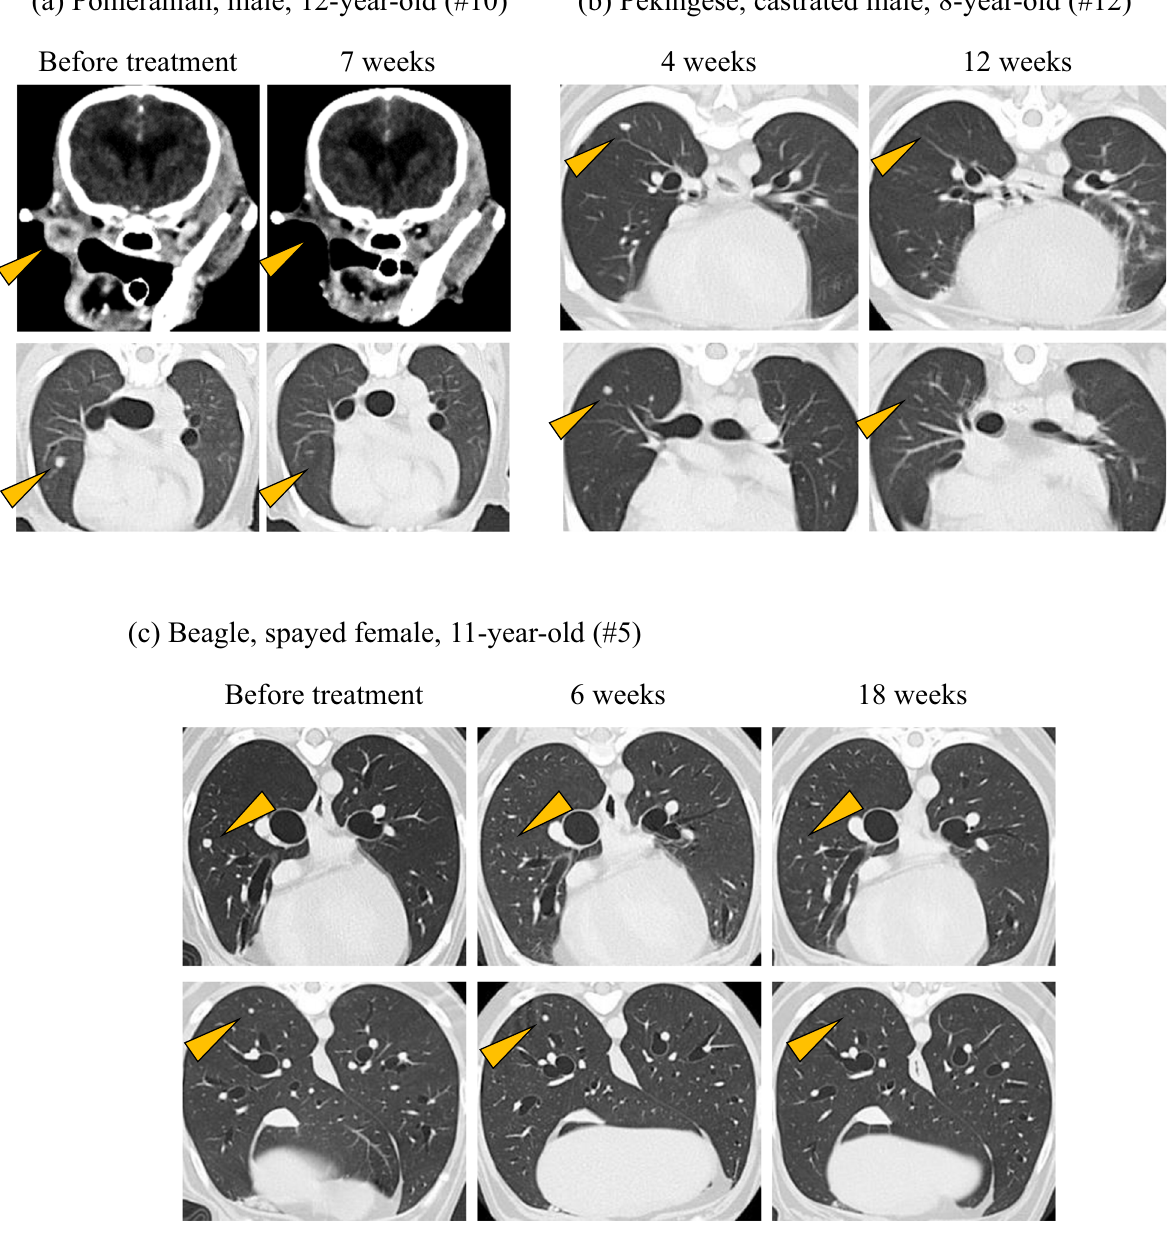
Fig. 2 Antitumor ef fi cacies of c4G12 in dogs with oral malignant melanoma. a Representative tumor response in dogs with measurable disease. The dog (Pomeranian, male, 12-year-old, #10 in Supplementary Tables 2, 3) received c4G12 at a dose of 5 mg/kg every 2 weeks. Oral recurrent tumor (upper panel) and pulmonary metastatic lesions (lower panel) responded to treatment at week 7. b , c Representative tumor response in dogs with non-measurable disease. b The dog (Pekingese, castrated male, 8-year-old, #12) received c4G12 at a dose of 5 mg/kg every 2 weeks. Pulmonary metastatic lesions were con fi rmed at week 4. Subsequently, the lesions responded to treatment at week 12. c The dog (Beagle, spayed female, 11-year-old, #5) received c4G12 at a dose of 5 mg/kg every 2 weeks until week 12 and thereafter the dose was changed to 2 mg/kg. A metastatic lesion in the lung (upper panel) disappeared at week 6. In contrast, the other lesion (lower panel) showed slight increase in tumor size at week 6, followed by complete regression at week 18 (an immune-related pattern of response). Contrast- enhanced and matched transverse CT images are shown. Arrow heads indicate tumor